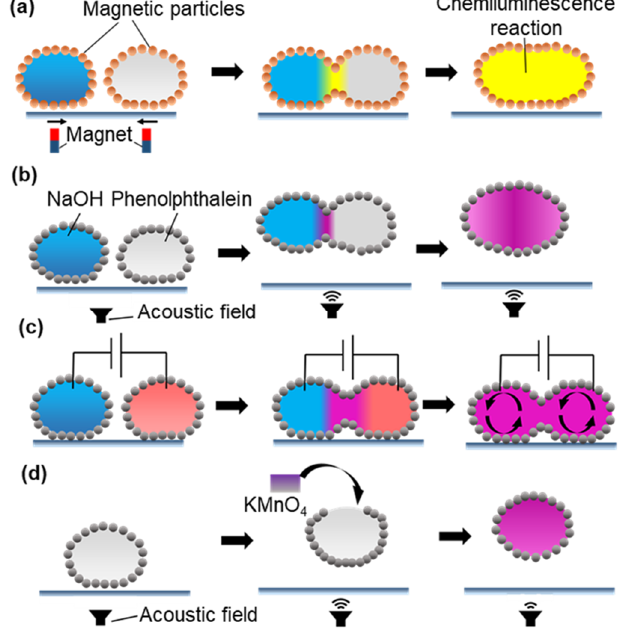
Figure 2. Manipulation of liquid marble-based microreactors. ( a ) Coalescence-driven chemiluminescence reaction of magnetic liquid marbles [34]. ( b ) Coalescence of liquid marbles containing NaOH and an indicator via acoustic levitation [35]. ( c ) Electrocoalescence and electromixing of liquid marbles [36]. ( d ) Opening, closing, and adding KMnO 4 into a liquid marble via acoustic levitation [38].